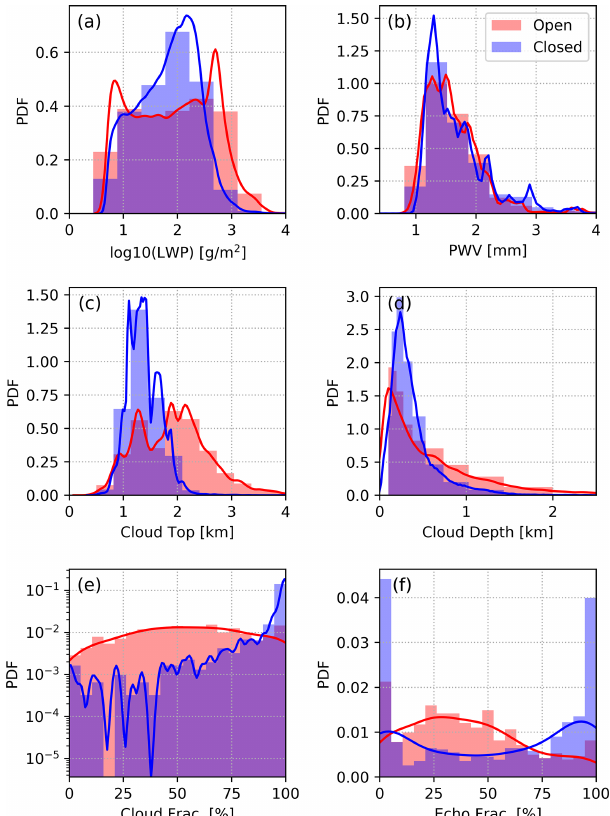
(d) cloud depth, (e) ceilometer cloud fraction (note: logarithmic scale on vertical axis), and (f) KAZR echo fraction for open- (red) and closed-cellular (blue) mesoscale organizations. The lines are the probability density functions (PDFs) calculated using Gaussian kernel density